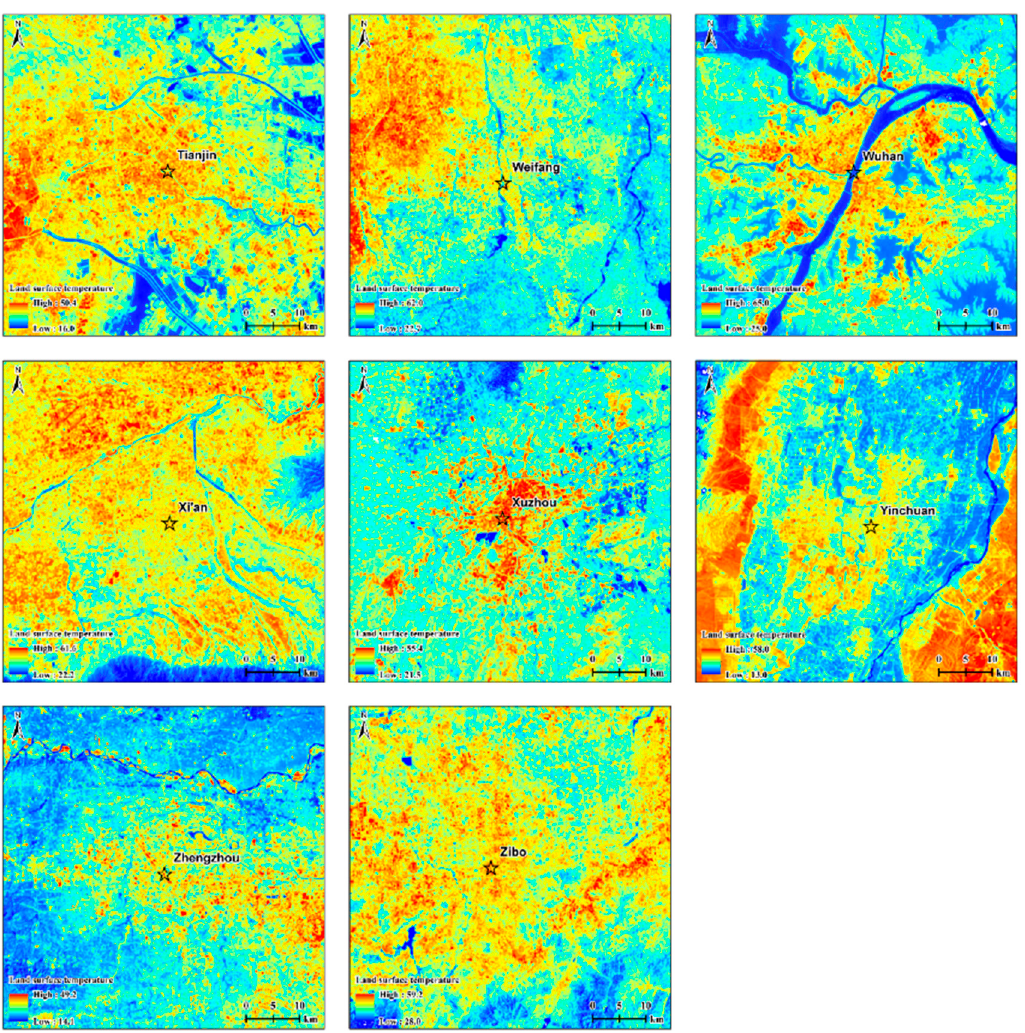
Figure A2. Map of the land surface temperature (LST) data for the 32 Chinese cities